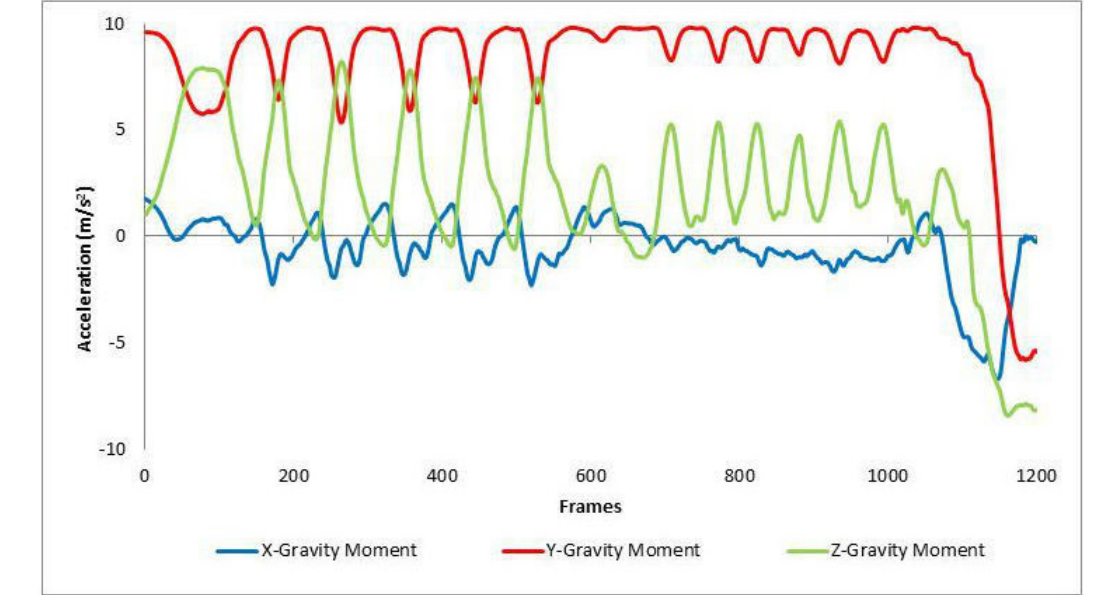
Figure 4. A graphical representation of the Stair Climb Test as captured by an iOS-based gravity sensor. Y-axis features represent changes in gravitational moments during stair ascent and descent.